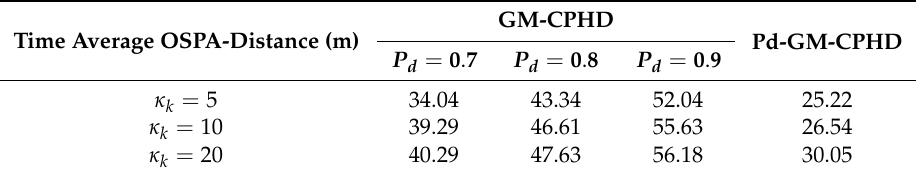
Table 3. Comparison of time average OSPA-distance (m) in different clutter environments. GM-CPHD: Gaussian Mixture Cardinalized Probability Hypothesis